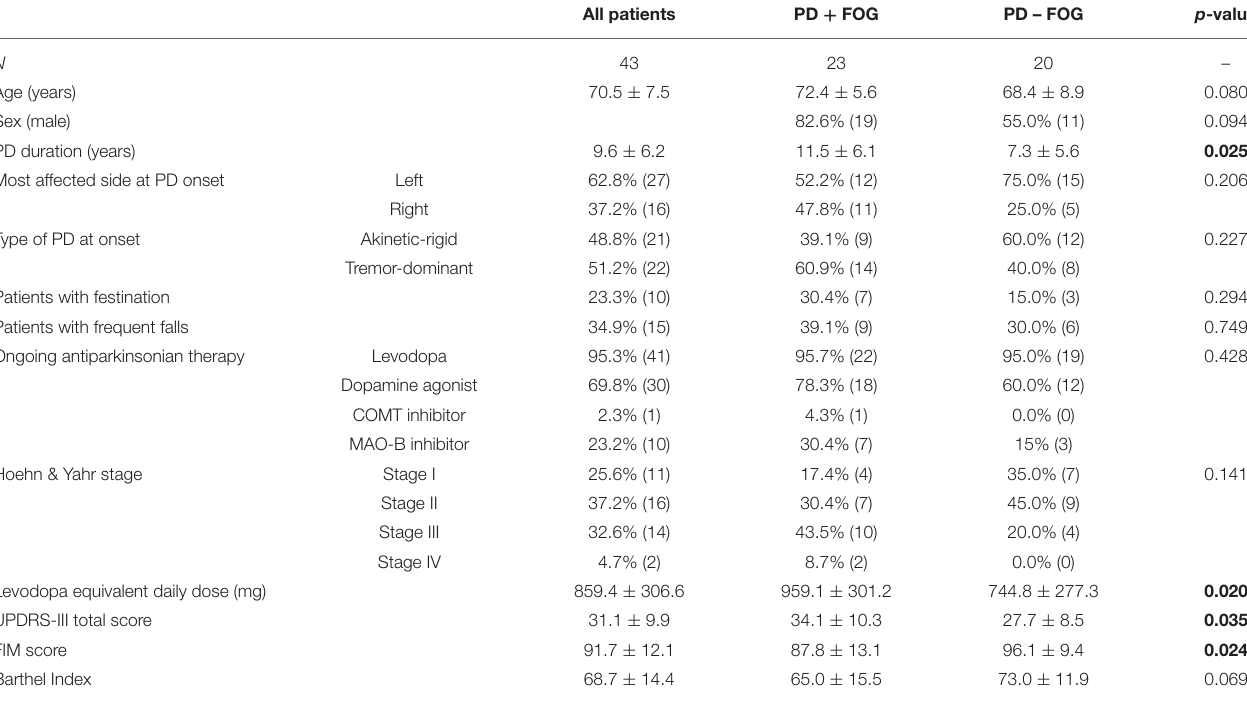
TABLE 1 | Baseline clinical and demographic features of the study population.